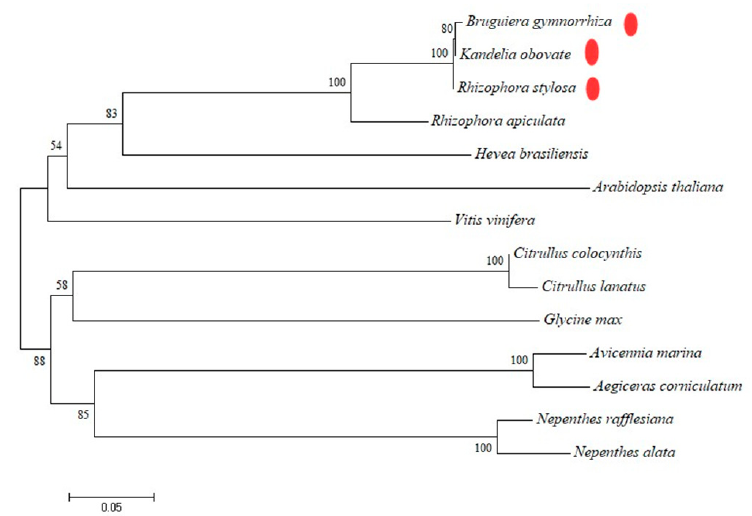
Figure 5. Phylogenetic tree of the CHI III. Multiple alignments of the sequences of CHI III and other selected plant chitinase were performed using MEGA 6. The three red point represents the chitinase of three mangrove plants in the figure.